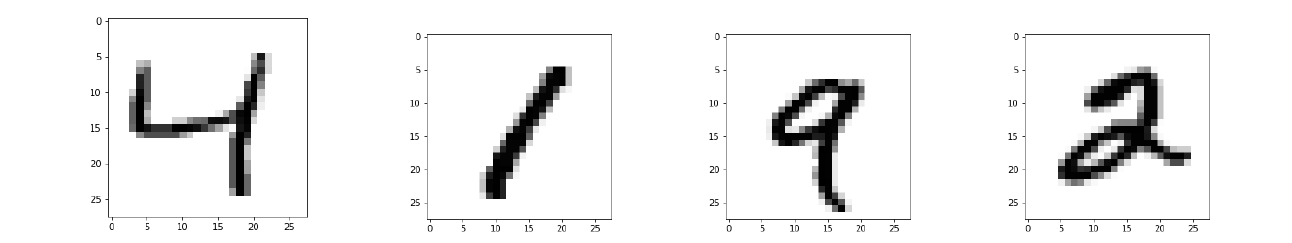
Figure 6. Four examples the 28 × 28 pixel images of the MNIST dataset, labelled as “4”, “1”, “9” and “2” from left to